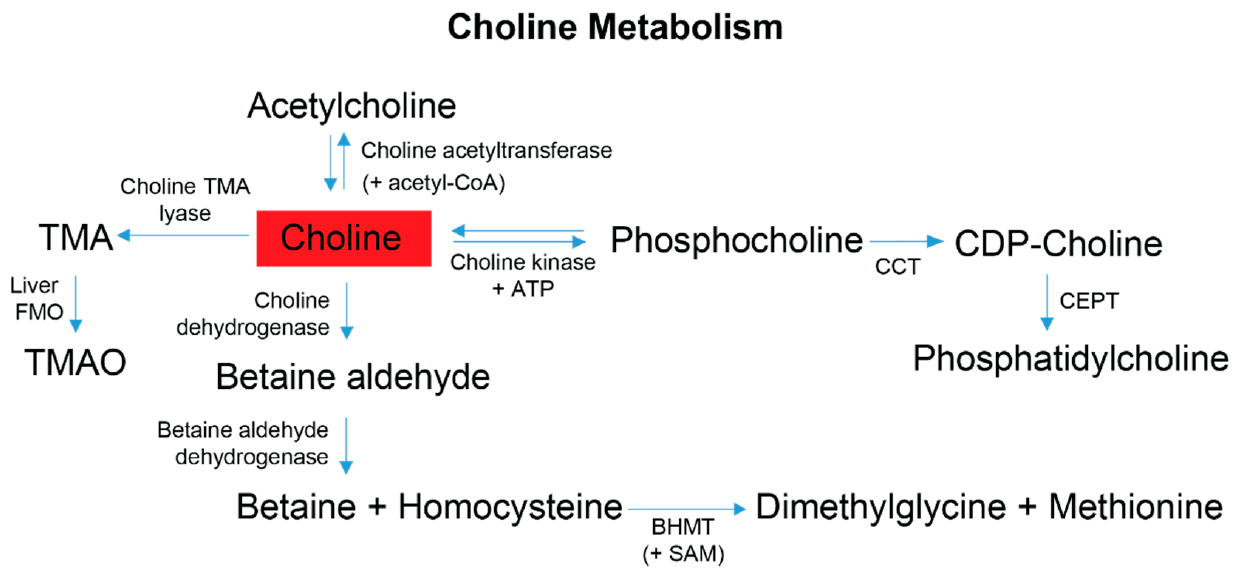
Figure 5. Choline is obtained primarily from the diet and contributes to four metabolic pathways employed by gut microbes and the host. Dietary choline is preferentially commi tt ed to the Kennedy pathway to produce phosphatidylcholine; this process is a 3-step reaction requiring initial ATP ex- penditure [75]. At the synaptic cleft, choline can also undergo a cyclical reaction to produce acetyl- choline for autonomic signaling transduction [66,76,77]. Within the liver and kidneys, choline can be converted to betaine, which is an osmotically active compound and a primary methyl donor that helps facilitate the re-methylation of homocysteine to methionine [66,68]. The production of TMA is mediated by the gut-microbiome. Following gut microbial conversion, TMA is classically absorbed by the gut epithelium, transported to the liver and converted by Flavin-monoxygenases (FMOs) to trimethylamine-N-oxide (TMAO) [51,66]. Red indicates choline was elevated in the stool metabo- lome of FD patients compared to their healthy relatives. Abbreviations: CoA, coenzyme-A; ATP, adenosine triphosphate; CPT, choline-phosphate cytidyltransferase; CDP, cytidyl-diphosphocho- line; CEPT, choline ethanolamine phosphotransferase; BHMT, betaine homocysteine methyl trans- ferase; SAM, S-adenosyl methionine; TMA, trimethylamine; TMAO, trimethylamine-N-oxide. Though an unambiguous conclusion cannot be made regarding the microbial spe- cies’ origins of the observed stool metabolite pa tt erns, an inference about gut health can